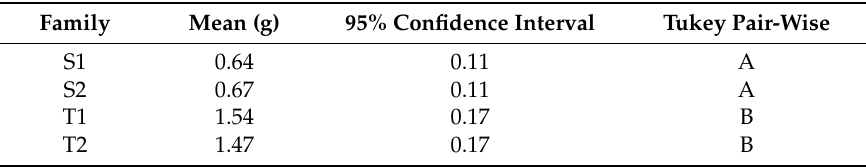
Table 9. Summary of seedling fine root dry matter yield (DMY, g) by